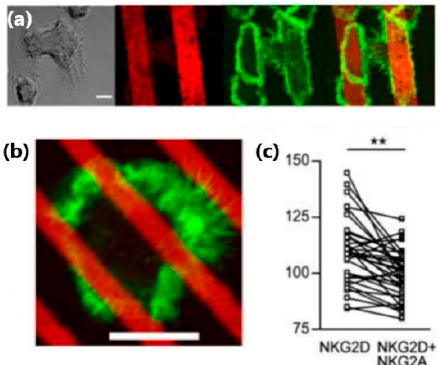
Figure 5. ( a ) NK cells on alternating strips of activating and inhibitory antibodies produced by microcontact printing. NK cells on strips of anti-NKG2D with isotope control mAb (bright filed), antiNKG2D strips (red), f-actin (phalloidin AlexaGluor4888, green), and mixture of the two latter. Scale bar: 25 µm. ( b ) NK cells on narrow lines of anti-NKG2D (red) interspersed with mixed anti-NKG2D and anti-NKG2A. Scale bar: 5 mm ( c ) F-actin distribution in regions of cells in contact with anti-NKG2D stripes or with a mixture of anti-NKG2A and anti-NKG2D (***, p < 0.001; n = 31 cells, paired t -test). Reproduced from Reference [48].